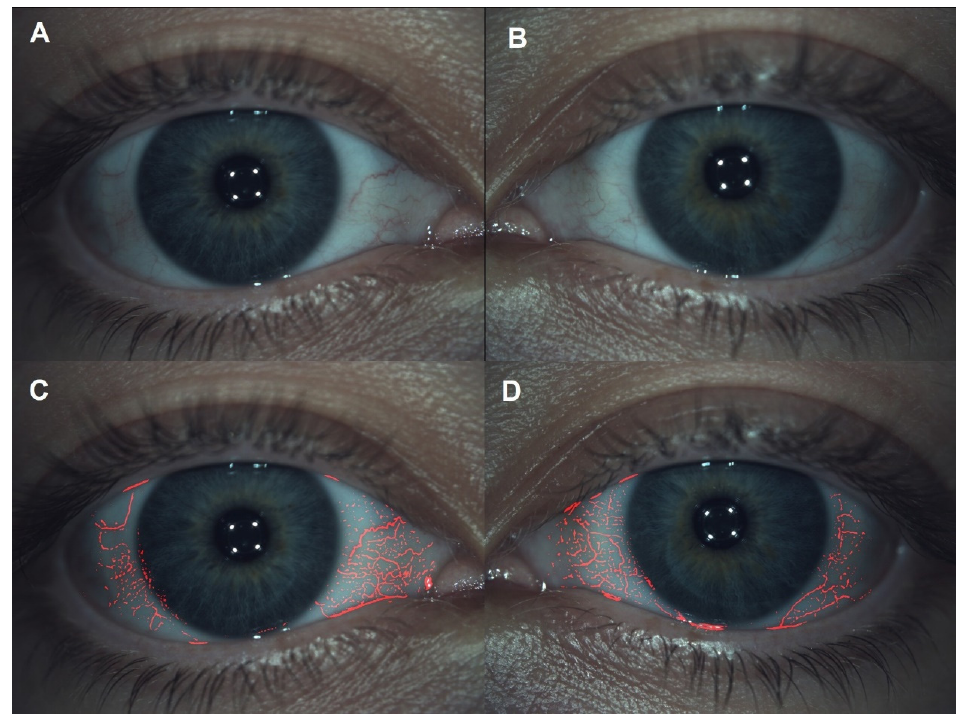
J. Clin. Med. 2022 , 11 , 3719 Figure 1. Limbal and bulbar grade 1 redness classification. ( A , C ) were right eyes. ( B , D ) were left eyes.